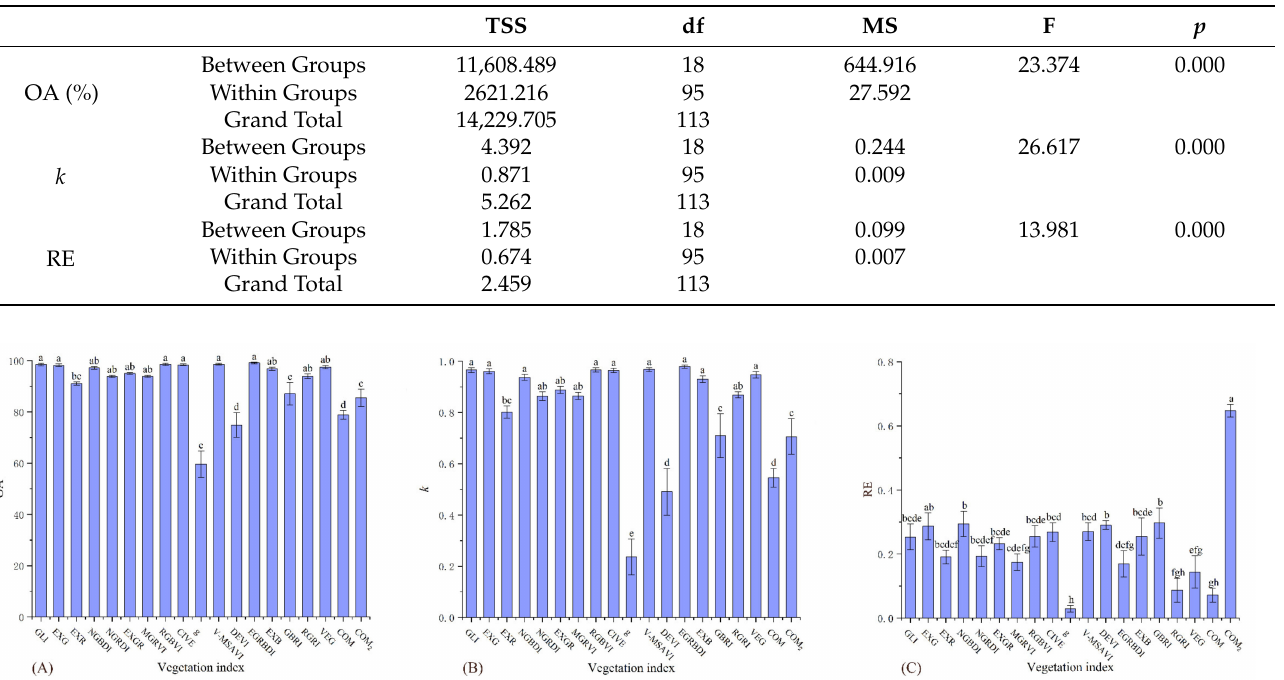
Table 7. OA, k , and RE differences of 19 vegetation indices on the slight desertification grade.